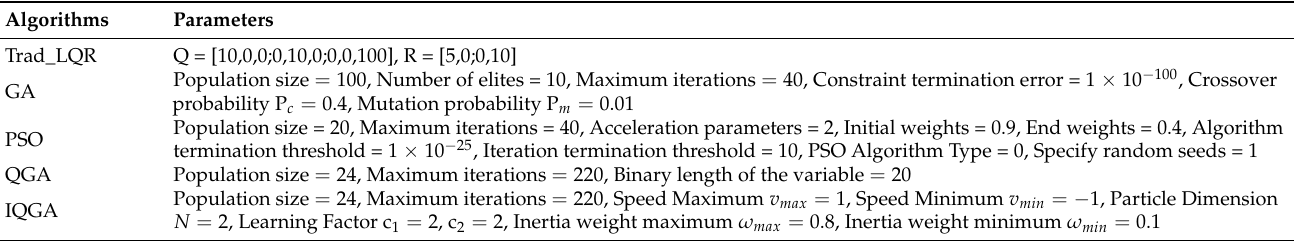
Table 1. Relevant parameters of each